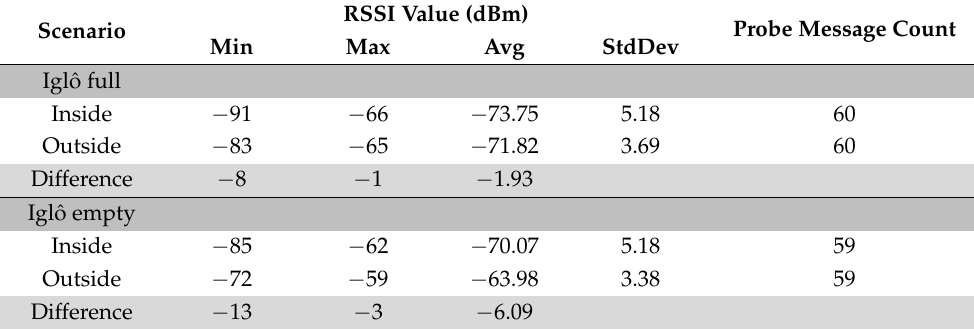
Table 2. RSSI measurements on Iglôs containing glass.